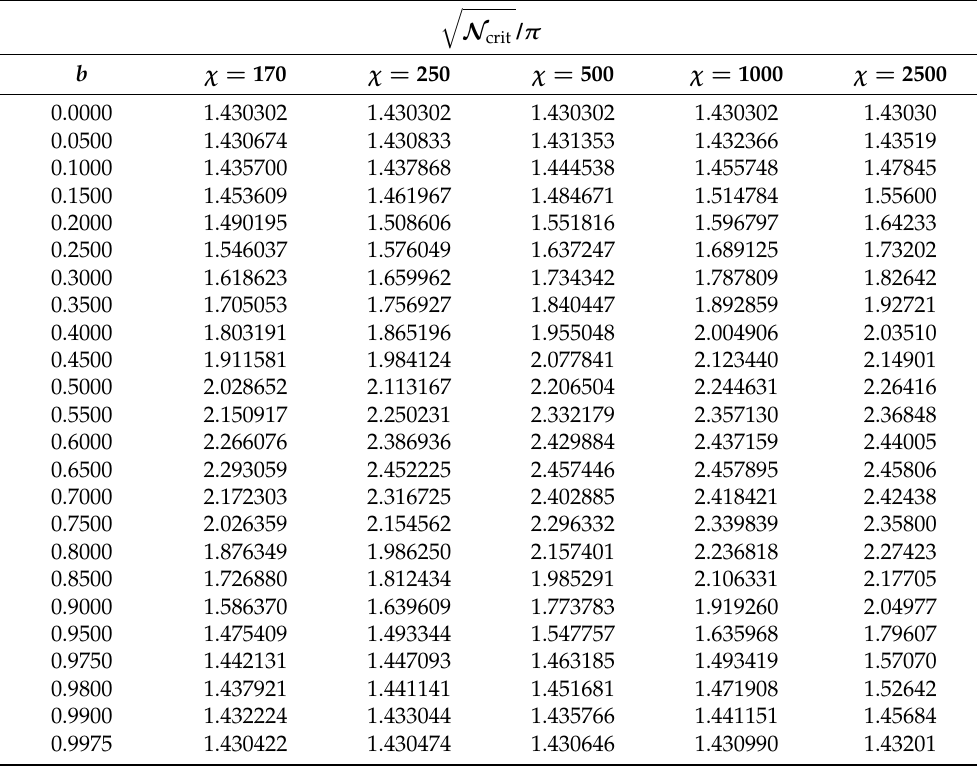
Table 5. The critical forces of FssP beams if χ = 170, . . .